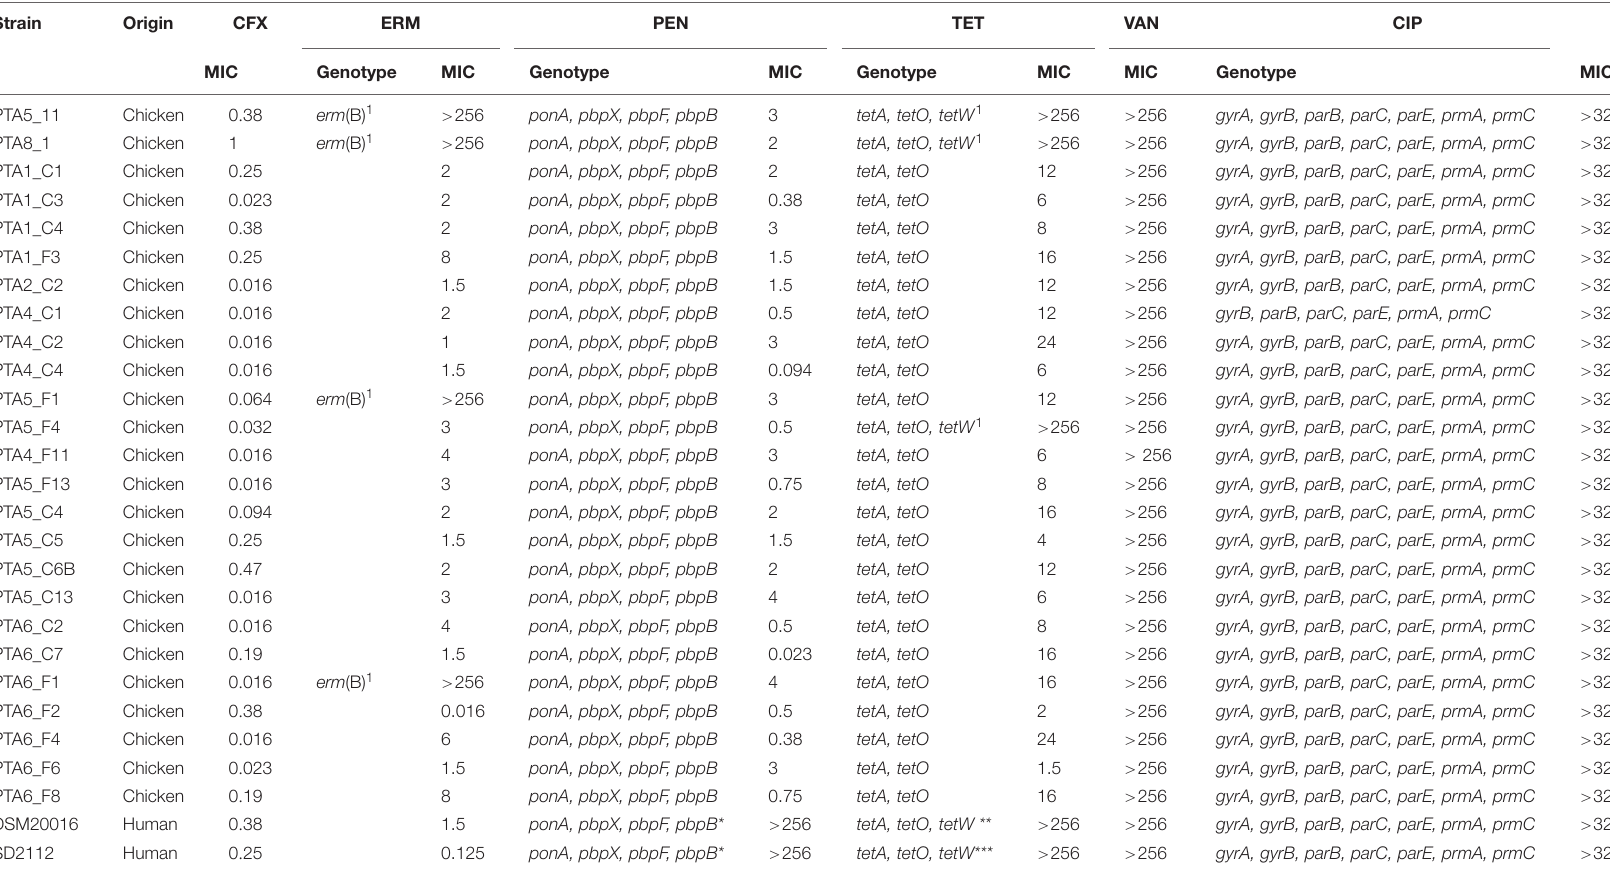
TABLE 2 | Antimicrobial resistance (AMR) profiles of 25 L. reuteri strains isolated from chicken in this study and of reference strains measured using MTS TM strips (MIC, µ g/mL), and associated AMR genes detected in their draft genomes.